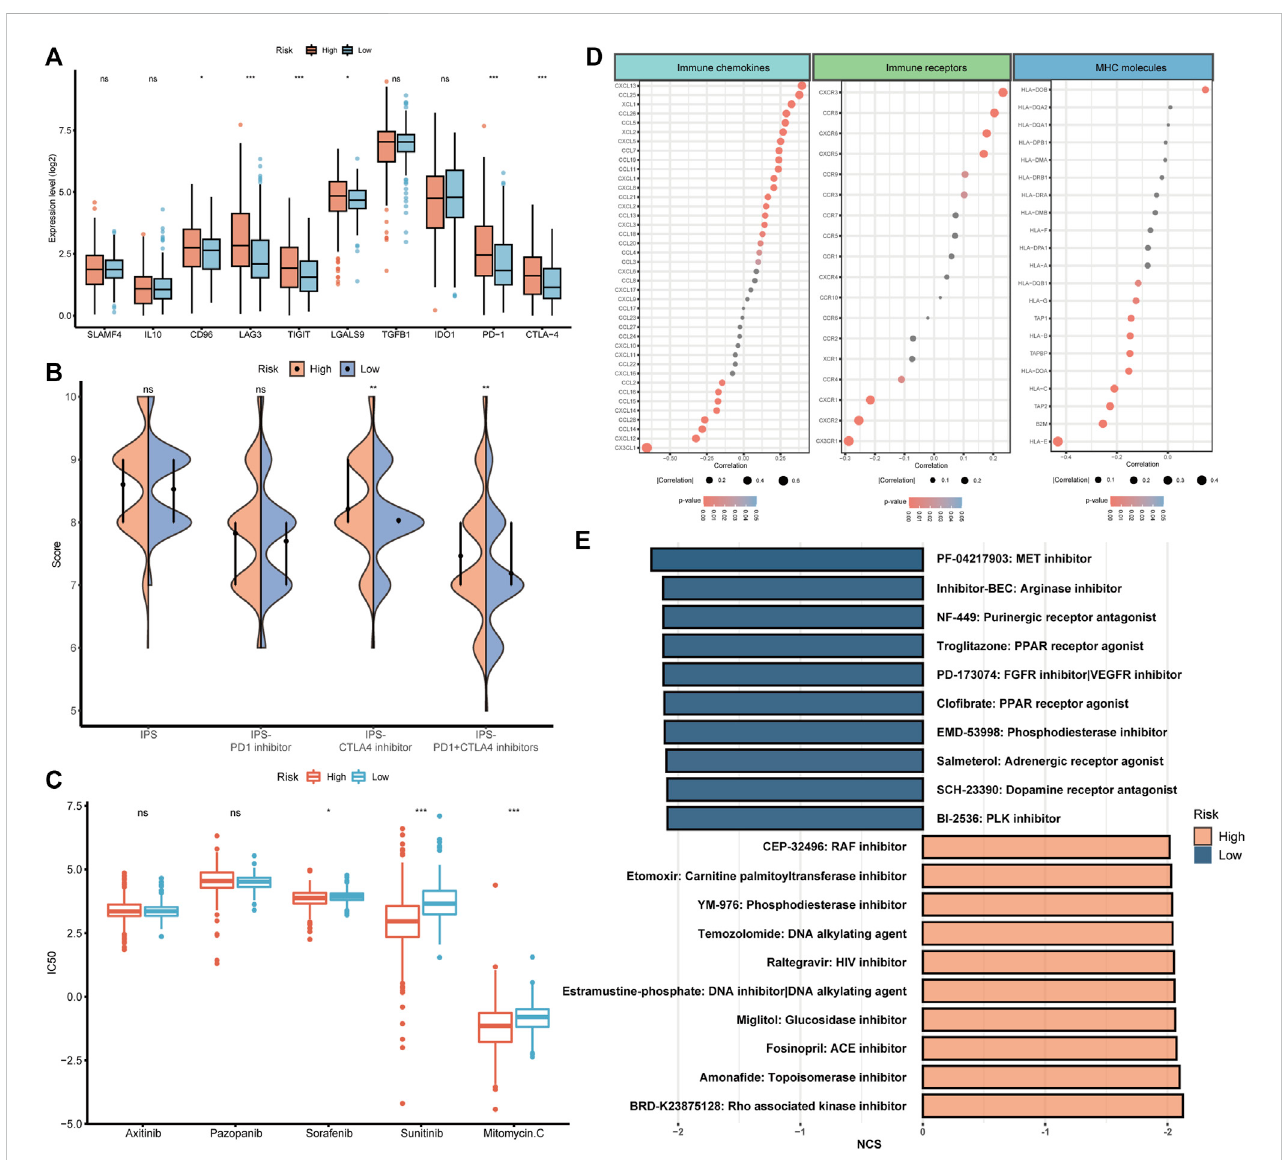
FIGURE 8 The potential of BMRS in guiding ccRCC treatment. (A) Comparison of the inhibitory immune checkpoint expression in different risk groups. (B) The IPS difference of4 types of ICI therapies in high and low BMRS groups. (C) Differential analysis of the IC50 of 5 therapeutic agents between BMRS risk groups. (D) Correlation between BMRS risk scores and the expression level of immune checkpoints, immune receptors and MHC molecules. (E) Potential therapeutic compounds predicted for high and low risk groups